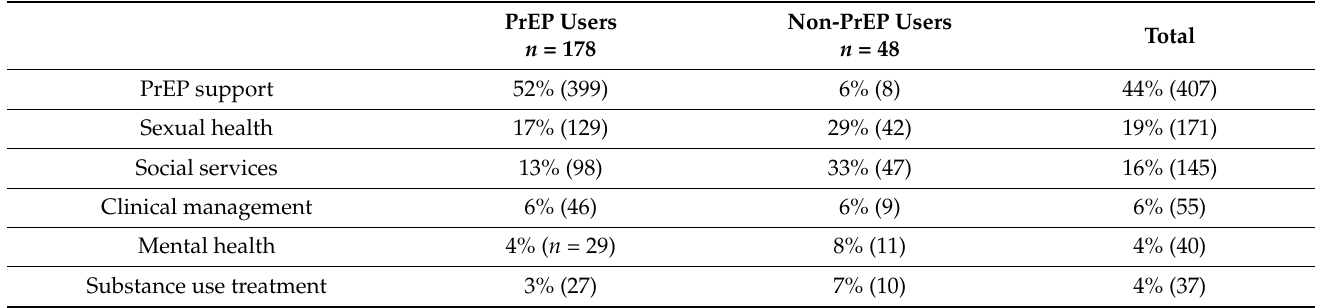
Table 2. Care coordination focus by PrEP use from enrollment to 52 weeks